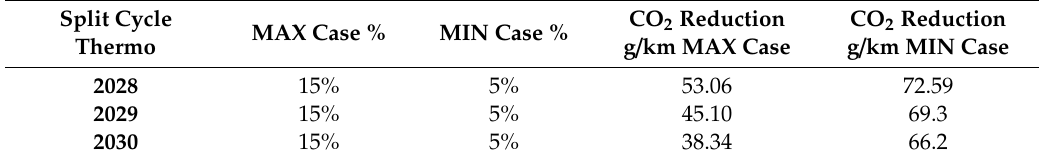
Table 8. CO 2 Reduction in Split Cycle Engine Technology.